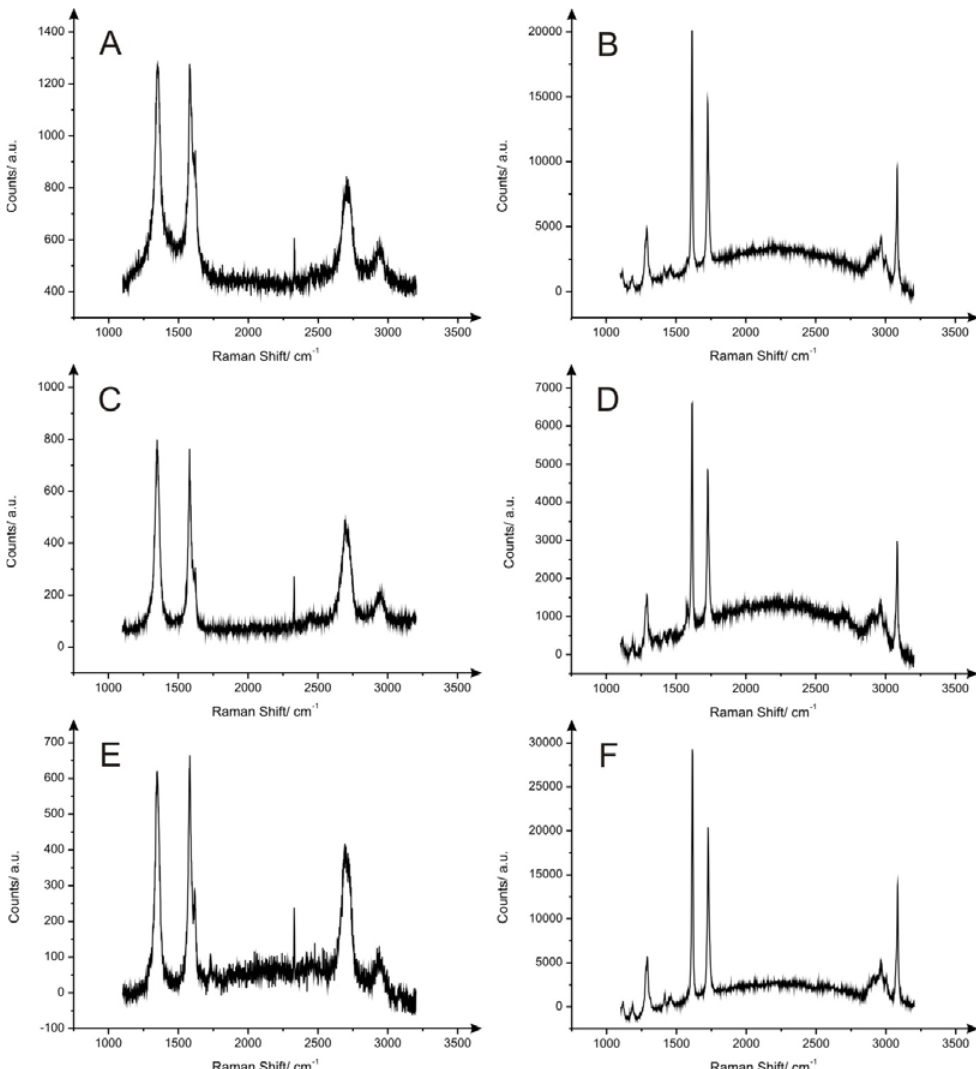
Figure S7. Raman results for PDEs (boxes 1–6) fabricated using different batches of HB pencils, designated as PDE1 ( A ), PDE2 ( B ), PDE3 ( C ), PDE4 ( D ), PDE5 ( E ) and PDE6 ( F ), respectively.